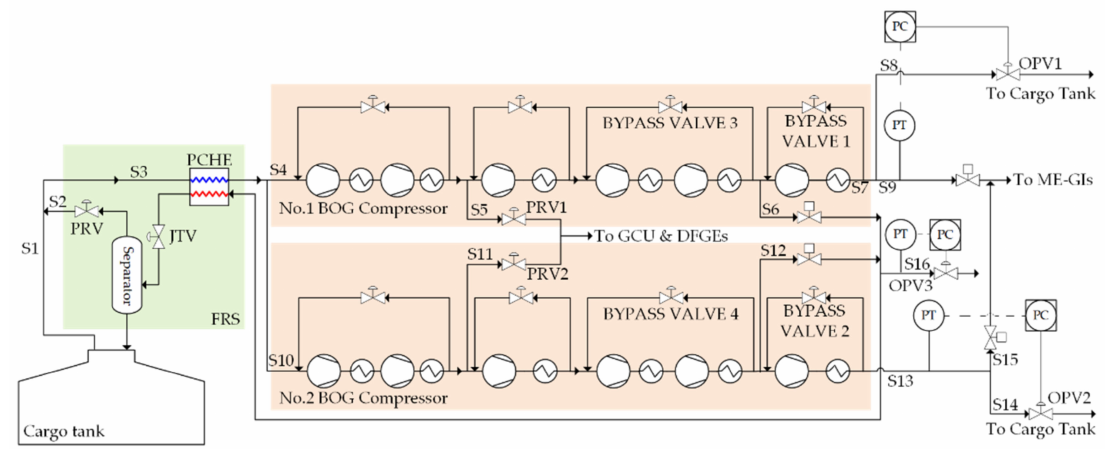
Figure 5. Configuration of a novel fuel gas supply system with a full re-liquefaction system (Case C).